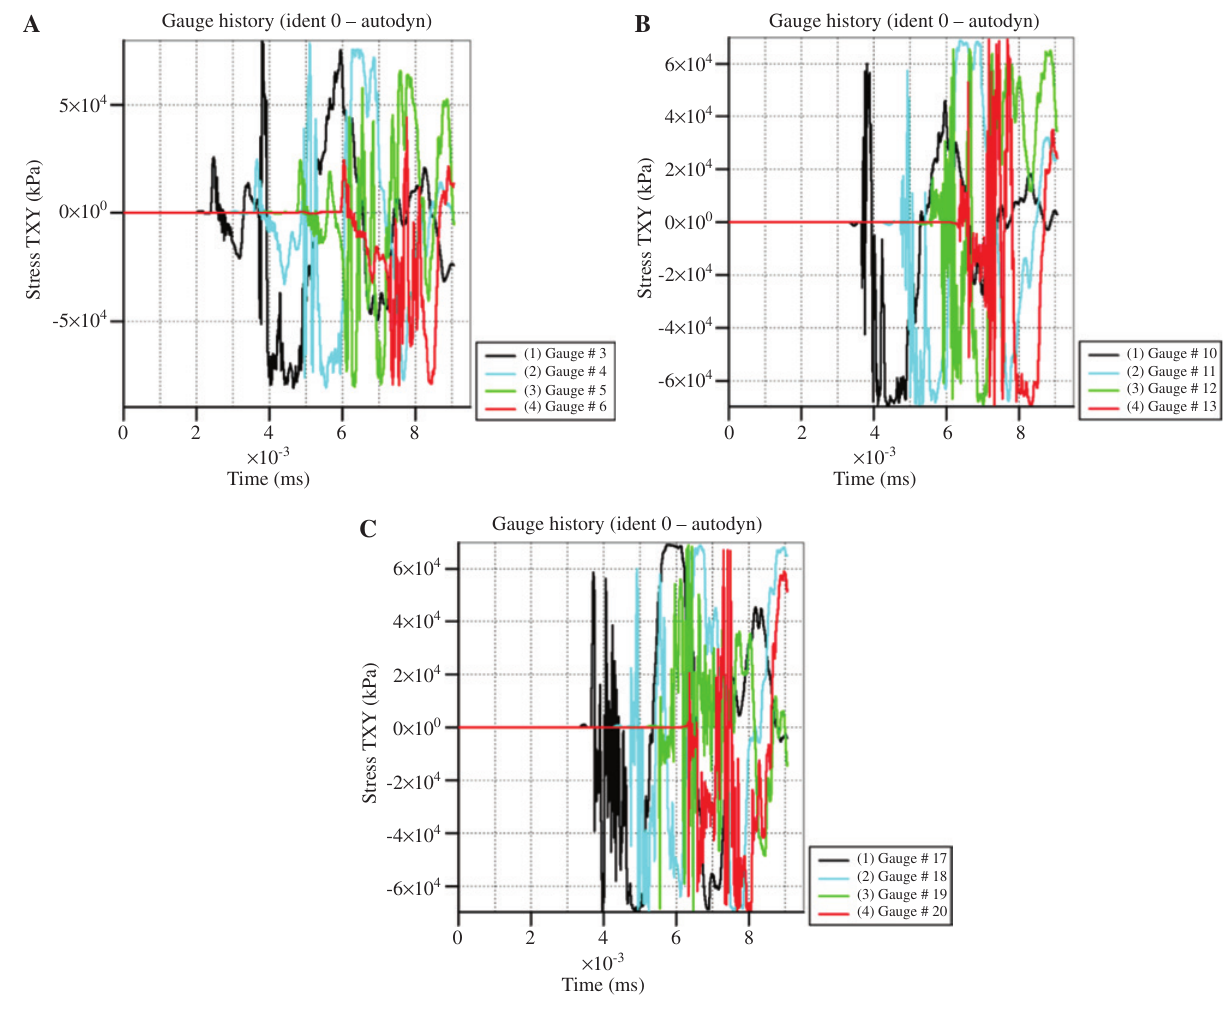
Figure 14: Stress TXY time curve along the direction of propagation of detonation: (A) the upper surface of aluminum alloy plate; (B) the lower surface of aluminum alloy plate; and (C) the upper surface of the magnesium alloy plate.